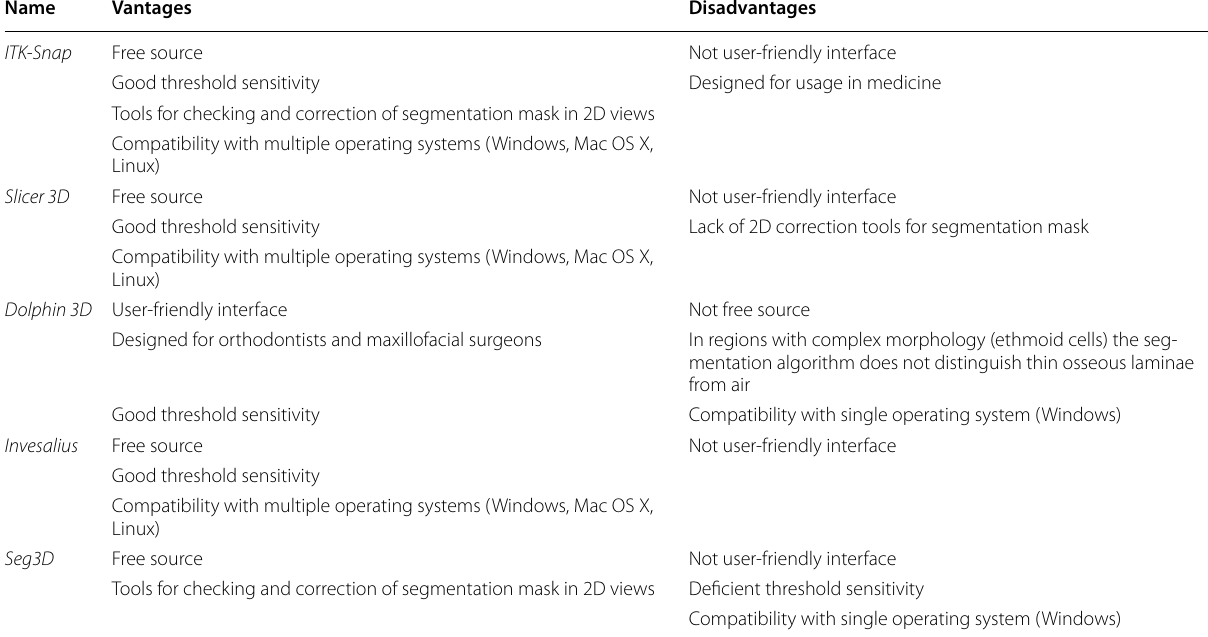
Table 5 Advantages and disadvantages of the 5 imaging softwares used in the present